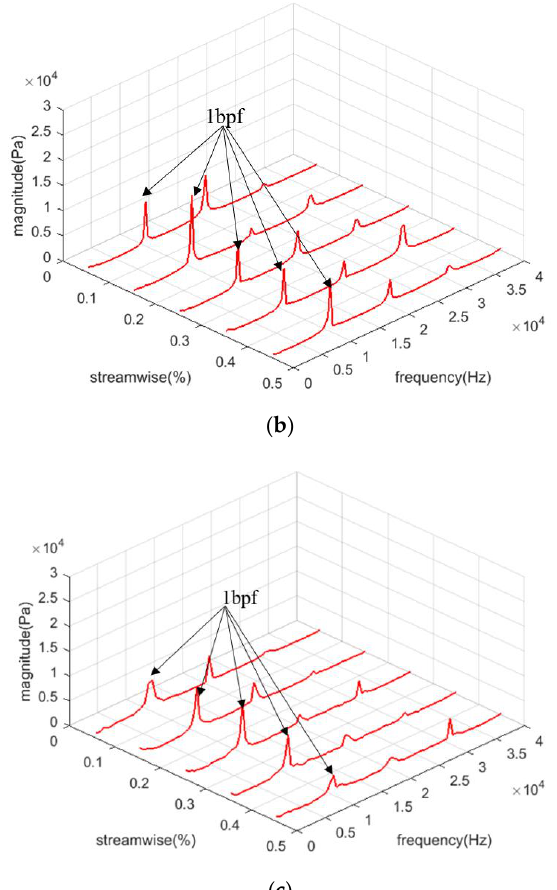
Figure 9. Frequency characteristic of the solid wall casing and axial slots of 10% and 20% area ratios. ( a ) Solid wall casing; ( b ) 10% slot area rate; ( c ) 20% slot area rate.